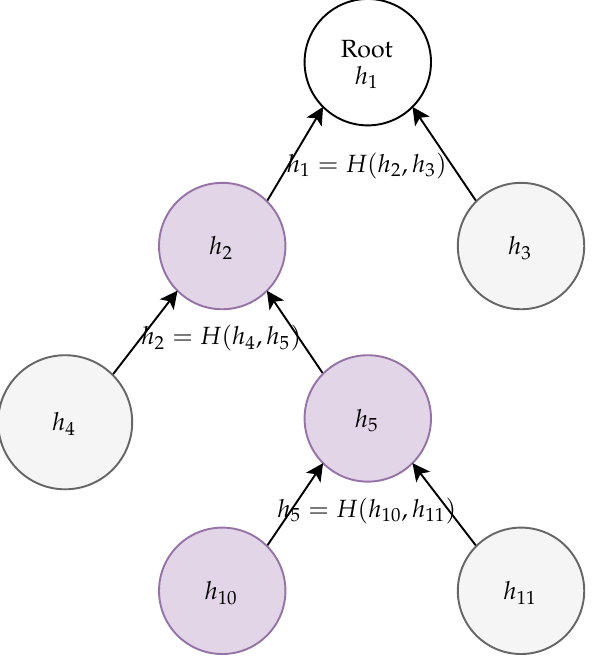
Figure 1. Example of a relevant part of a Merkle tree. The validity of h 10 can be verified, if we provide hashes h 11 , h 4 , and h 3 : Firstly, we compute h (cid:48) we verify that h 1 = hash ( h (cid:48)